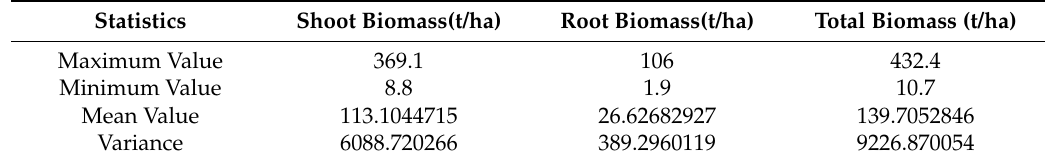
Table 1. The statistical information of the field-measured